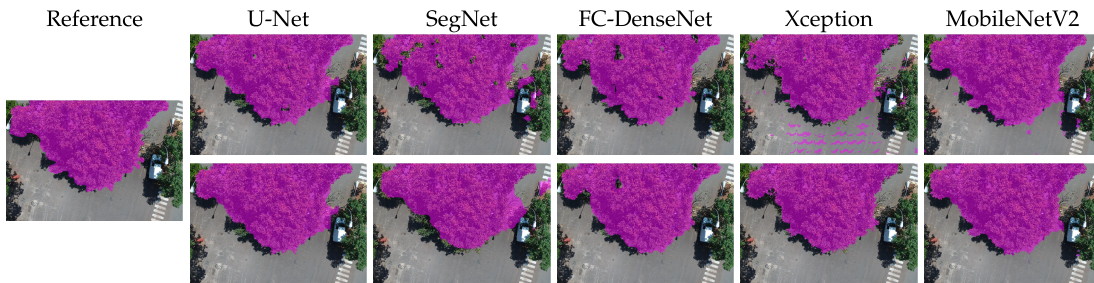
Figure 11. Sample Segmentation 2 prior (first row) and after CRF post-processing (second row).